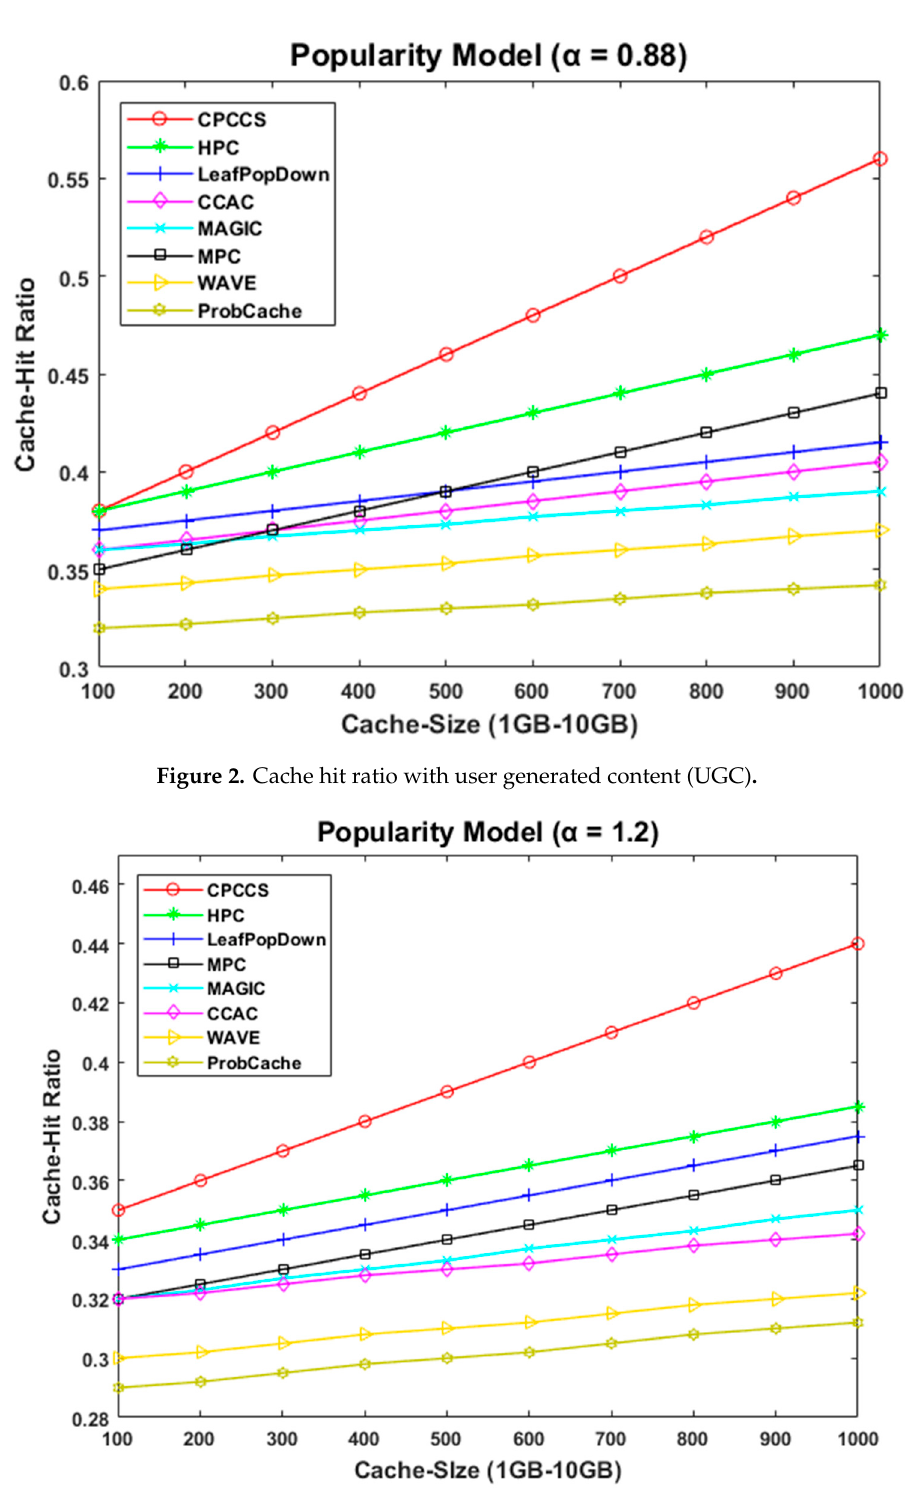
Figure 3. Cache hit ratio with video on demand (VoD) .